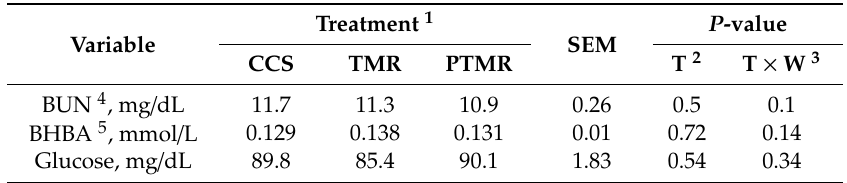
Table 5. E ff ect of feeding conventional calf starter and oat hay as TMR or in pelleted form on preweaning BUN, BHBA, and glucose concentration of crossbred